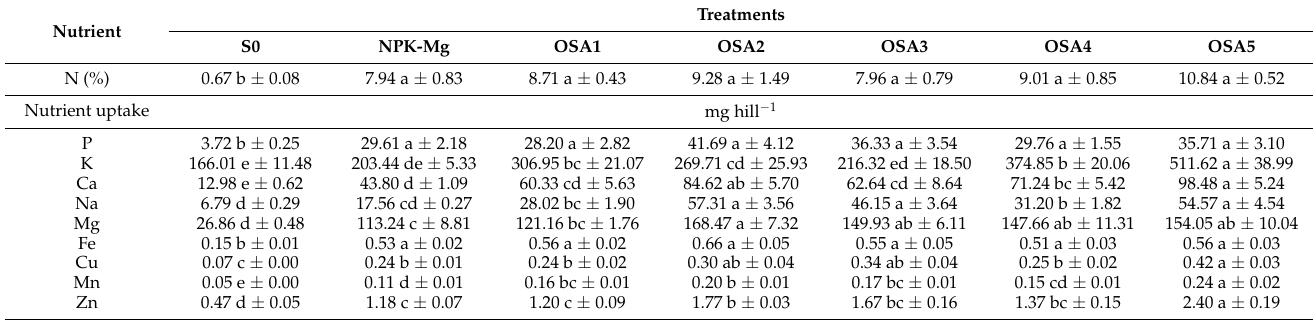
Table 10. Total nitrogen and nutrients uptake by MR219 rice plants as affected by residual organic soil amendments during the third cropping